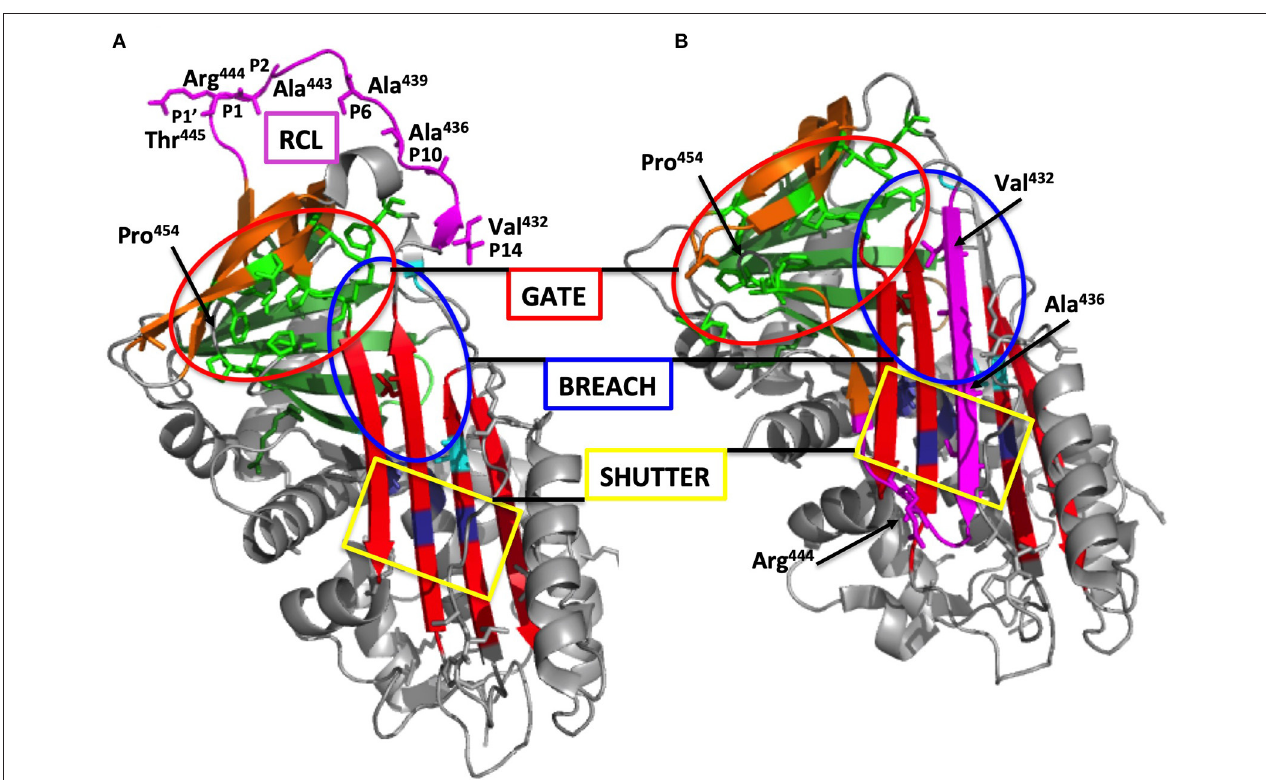
FIGURE 3 | Overall structure of C1-INH. (A) Native C1-INH serpin domain, with positions of strategic residues shown with side chains in sticks. Five regions for the serpin function are presented on the 3D-model of C1Inh (PDB ID 5DU3) presented using Pymol. The model starts at Phe 100 and lacks a great part of the N-terminal domain (residues 1-112). Strategic functional regions are indicated with (i) the reactive site loop (RCL), colored purple, including Arg 444 P1 and the hinge region (P15-P9), essential for protease recognition, RCL mobility and conformational transformation for its insertion as strand 4A (s4A) (i.e., S to R transition, after protease inhibition); (ii) the central β -sheet A , colored red, with the breach region, indicated by a blue ellipse, located at its top and point of initial insertion of RCL, and the shutter domain, with a yellow rectangle, close to the center of β -sheet A, that, with breach , assists sheet opening and accepts the insertion of conserved proximal hinge s4A between s3A and s5A; (iii) the gate , highlighted with green sticks and targeted with a red ellipse, including s3C and s4C of β -sheet C. β -sheets B and C are colored green and brown, respectively. (B) Latent form of C1-INH. The same regions involved in the serpin function but in a nonfunctional conformation where RCL is kept inside the central β -sheet A structure with additional s4A colored purple and remaining inaccessible to target proteases (PDB ID 20AY). Residue numbering was done according to mature C1-INH protein. Pictures were drawn by Dr. Christine Gaboriaud, Institut de Biologie Structurale, Grenoble